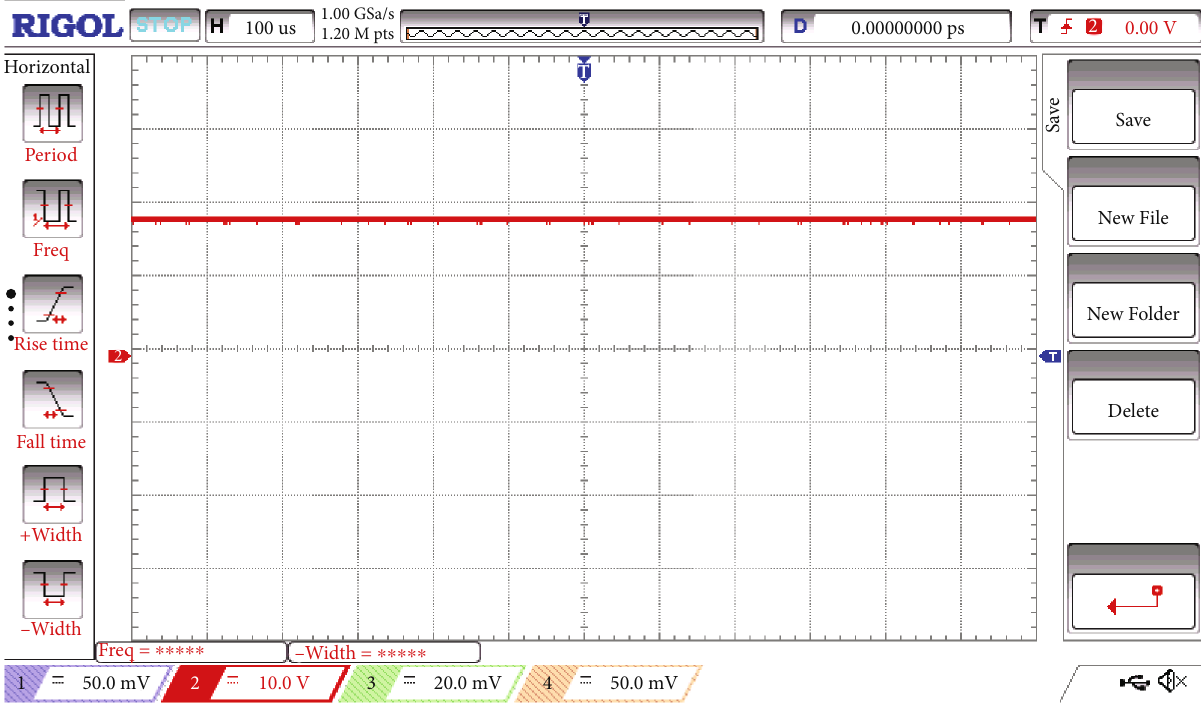
Figure 19: Solar PV terminal voltage.